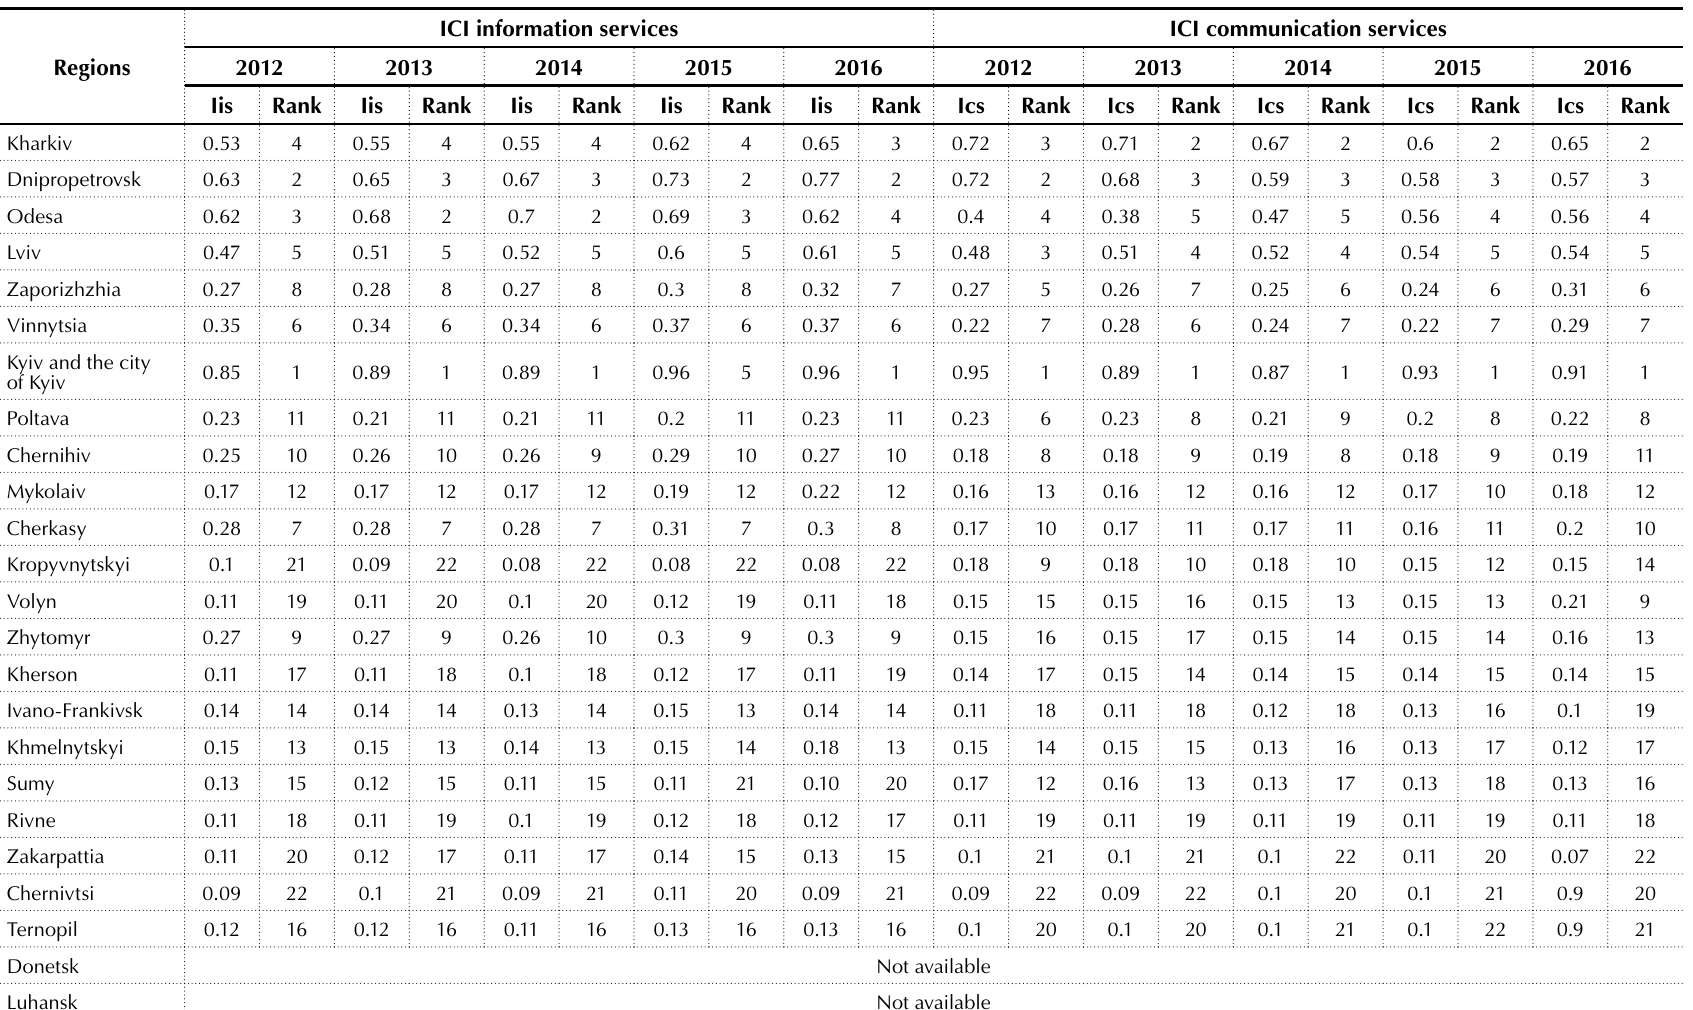
Table 1. Integral indicators and ranks of ICI development in the Ukrainian regions